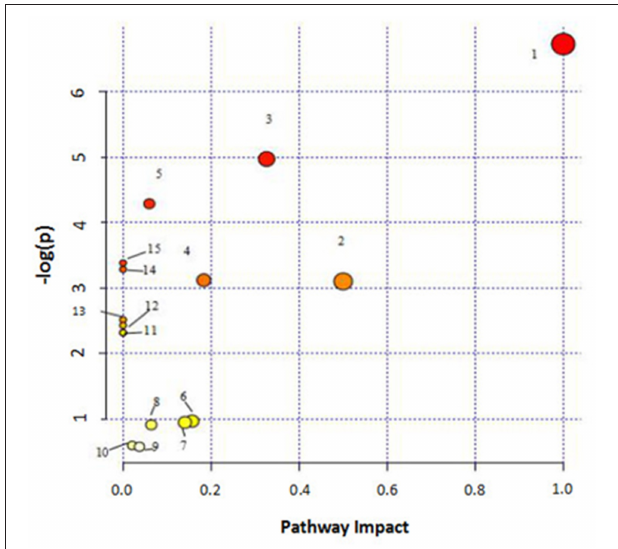
FIGURE 8 | Main metabolic pathways of potential biomarkers. Linoleic acid metabolism; (2) Phenylalanine, tyrosine and tryptophan biosynthesis; (3) Arachidonic acid metabolism; (4) Glycerophospholipid metabolism; (5) Primary bile acid biosynthesis; (6) Tryptophan metabolism; (7) Tyrosine metabolism; (8) Arginine and proline metabolism; (9) Steroid hormone biosynthesis; (01) Purine metabolism; (11) alpha-Linolenic acid metabolism; (12) Taurine and hypotaurine metabolism; (13) Biosynthesis of unsaturated fatty acids; (14) Aminoacyl-t RNA biosynthesis; (15) Ubiquinone and other terpenoid-quinone